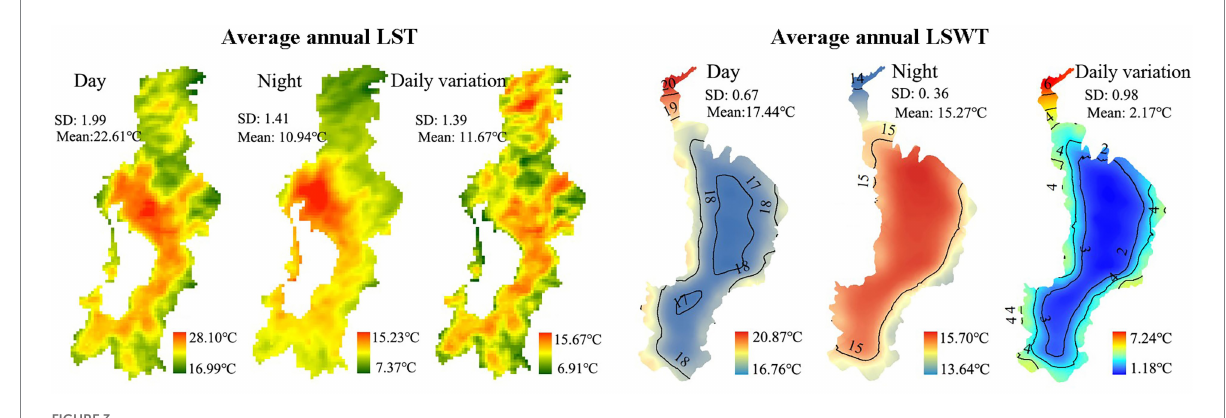
FIGURE 3 Spatial distribution of annual mean from 2001 to 2018.